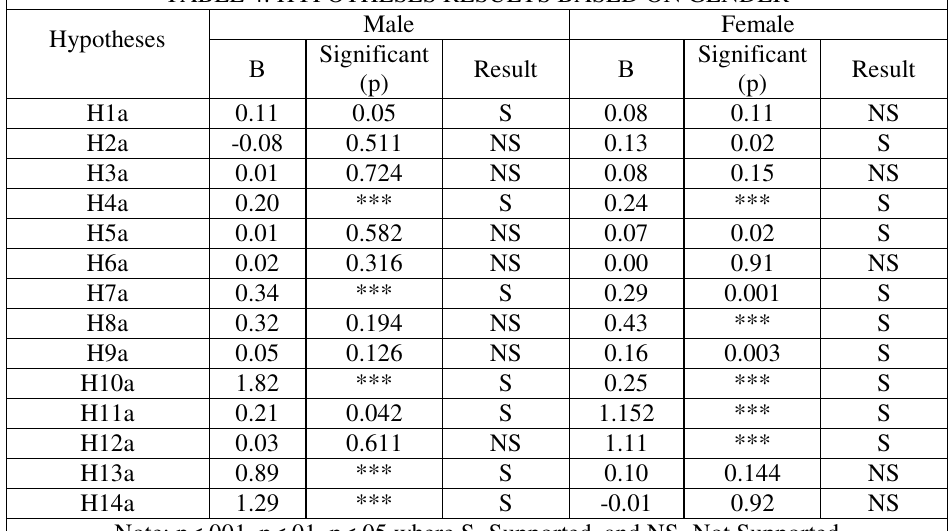
TABLE 4: HYPOTHESES RESULTS BASED ON